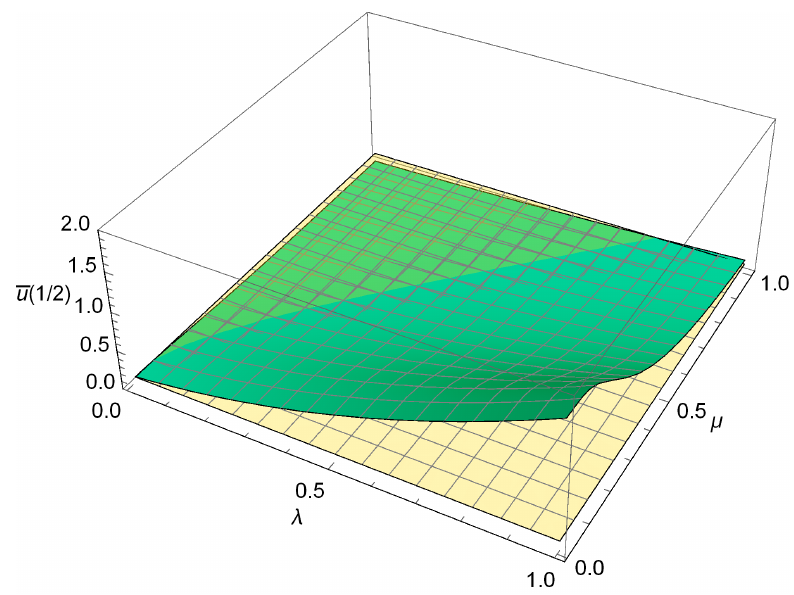
Figure 10. CC nano-rod subject to a uniformly distributed axial load. 3D plot of the non-dimensional maximum axial displacement ¯ u ( 1/2 ) vs. the non-dimensional characteristic parameters λ and µ . The non-dimensional local maximum axial displacement ¯ u e ( 1/2 ) = 1/8 = 0.125 is the horizontal plane.